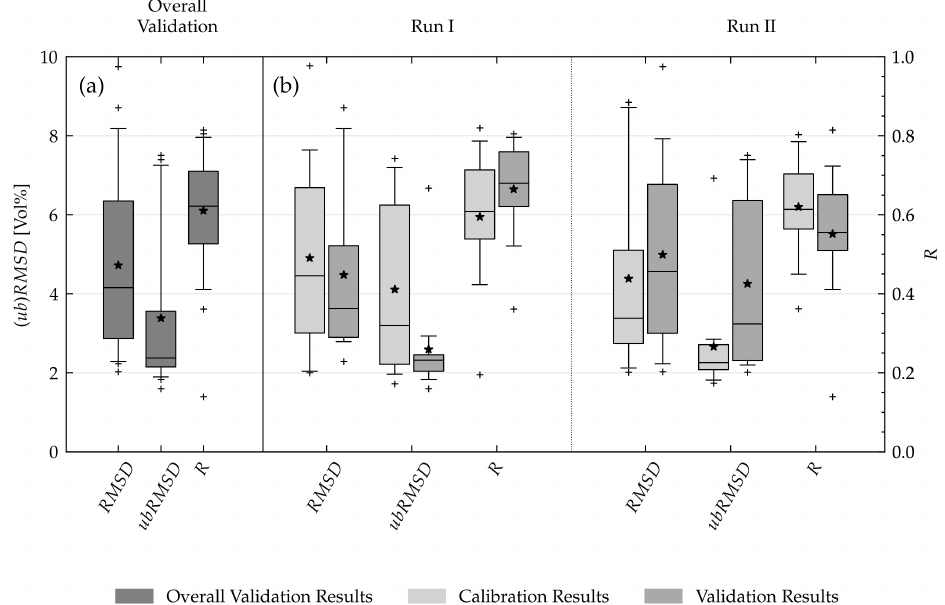
Figure 4. Results of the two-fold cross-validation showing spread of RMSD , ubRMSD and R in validation stations of ( a ) both runs combined and ( b ) in respective calibration and validation stations from each run. Outliers (+) are defined exceeding 2.7 σ , asterisks (*) show the mean of the respective distribution. Summary of values listed in Table